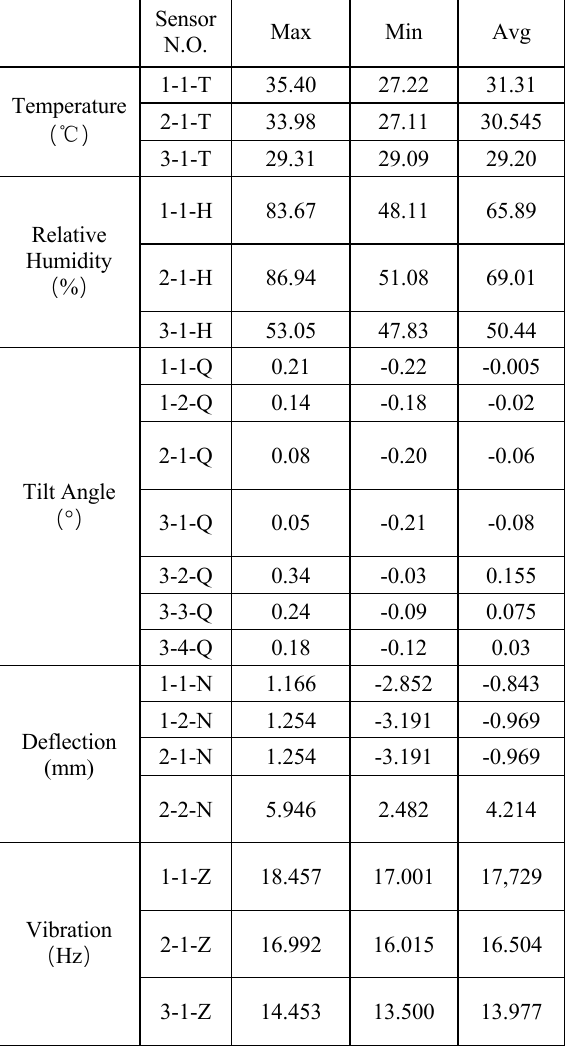
Table 1. Data gained in August for